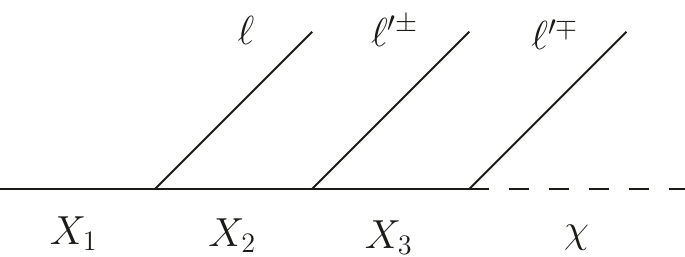
Figure 2 . The speci(cid:12)c realization of the event topology from (cid:12)gure 1(d) which will be studied in this paper. Here ‘ 0(cid:6) and ‘ 0(cid:7) is a pair of opposite-sign, same-(cid:13)avor leptons, while ‘ is a third lepton of a di(cid:11)erent